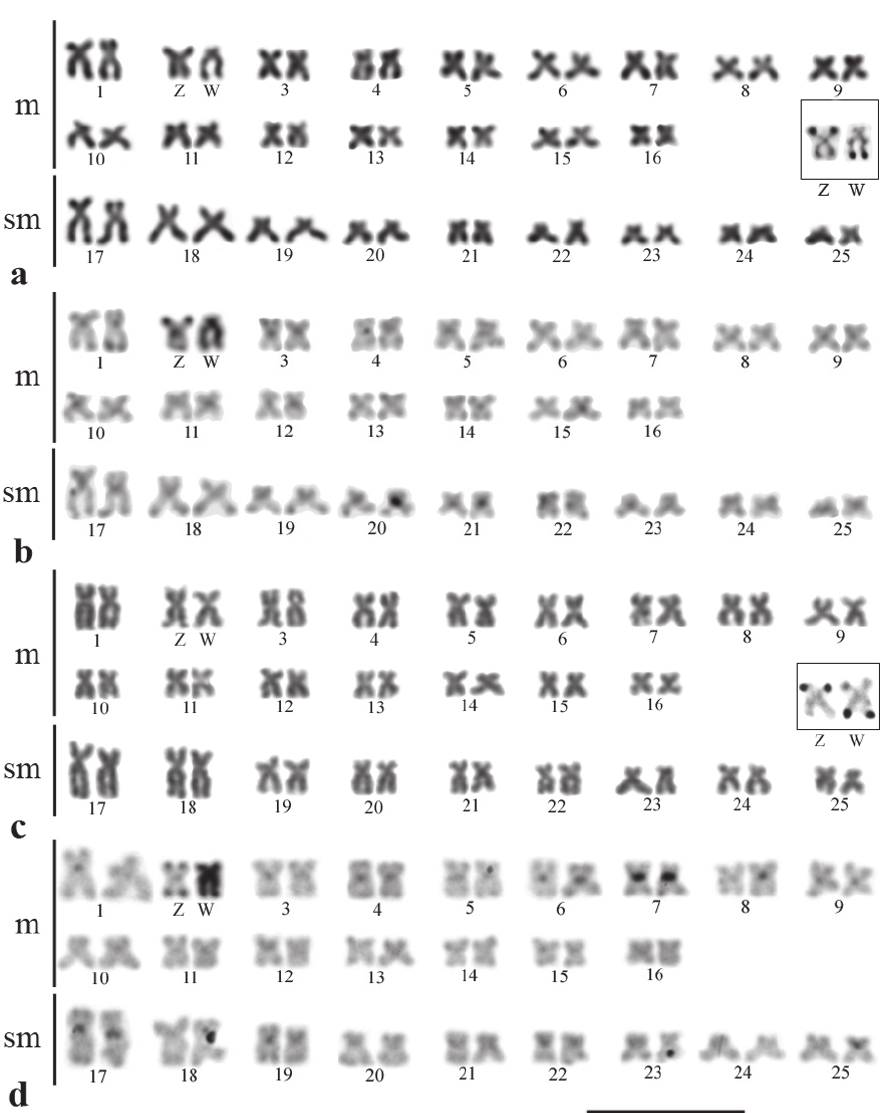
Fig. 4. Karyotypes of female specimens of Characidium sp. from Itanhaém, SP, and Characidium schubarti from Jaguariaiva, PR, after conventional Giemsa staining (a, c) and C-banding (b, d), respectively. Note conspicuous heterochromatic blocks in the centromeric region of some chromosome pairs and the differentiated sex chromosomes, being the W almost completely heterochromatic in both species. In the box, the Z and W chromosomes carrying the NORs in an inverted position. Scale bar = 10